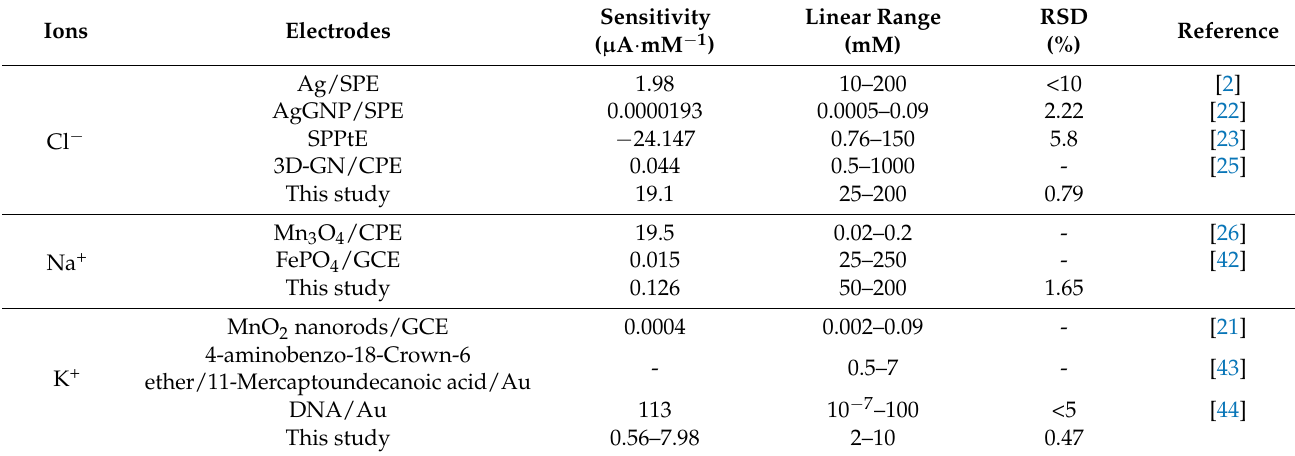
Table 2. Performance comparison of the proposed ion detection electrode and existing technologies. Ions